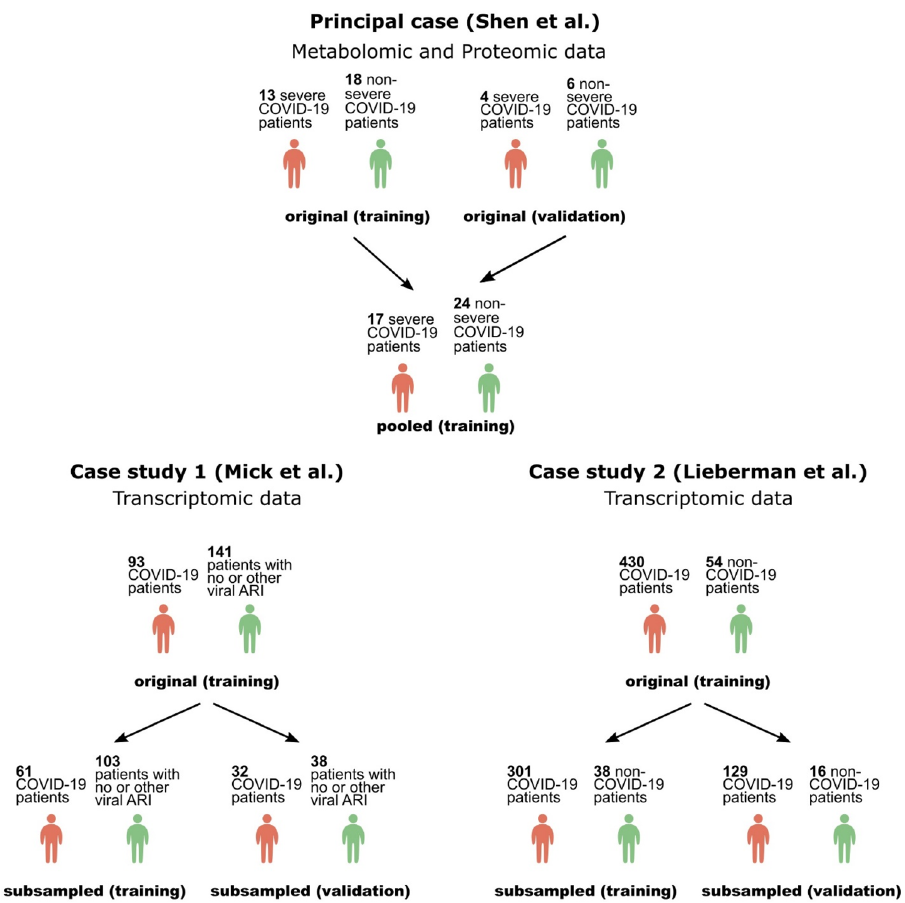
Figure 1. Graphical summary of the COVID-19 datasets re-analyzed in our study. Principal case: Public data from Shen et al. originally include measurements from two independent cohorts, one used for model